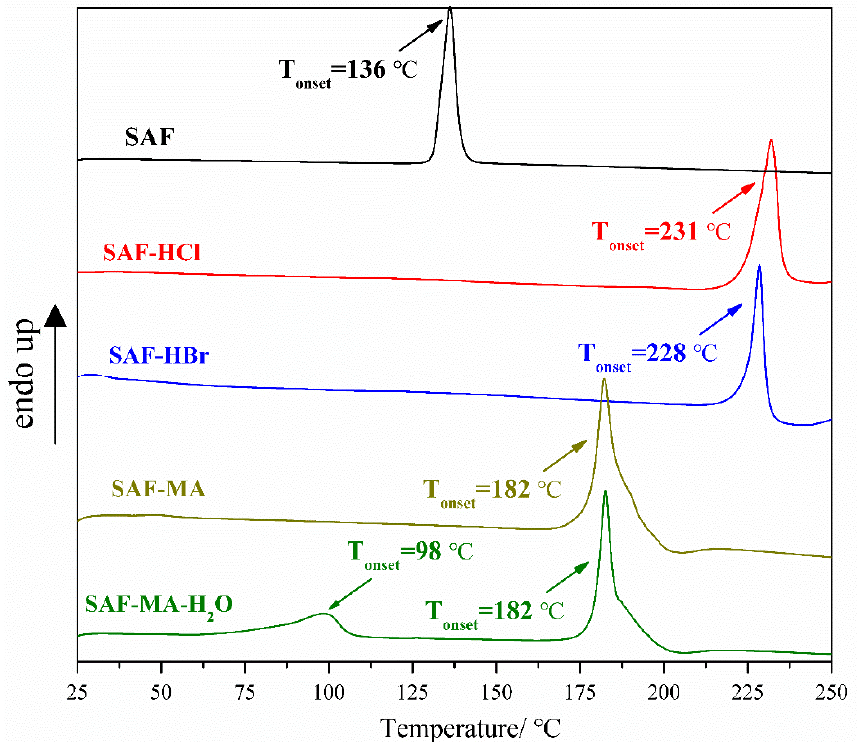
Figure 7. Di ff erential scanning calorimetry thermograms of SAF, SAF-HCl, SAF-HBr, SAF-MA, Figure 7. Differential scanning calorimetry thermograms of SAF, SAF-HCl, SAF-HBr, SAF-MA, and and SAF-MA-H 2 O SAF-MA-H 2 O salts.